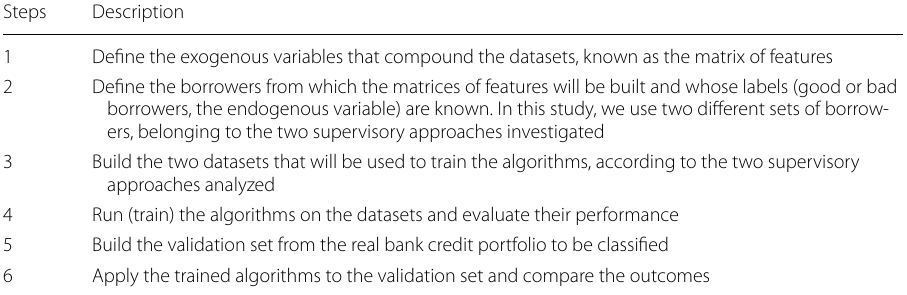
Table 2 Building a machine learning based classification device